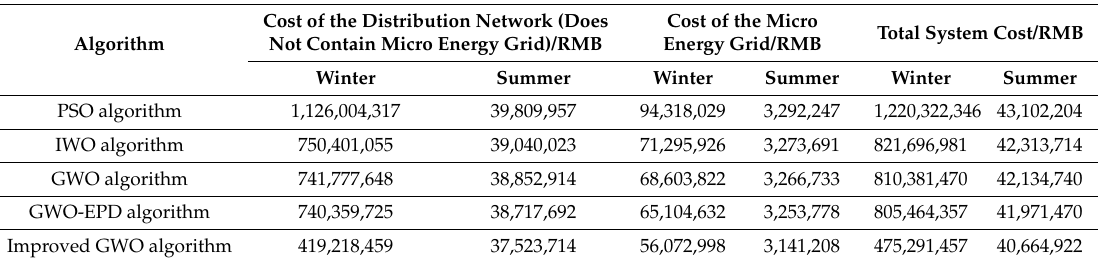
Table 6. Daily cost of the distribution network comprising the micro energy grid using five algorithms—the particle swarm optimization (PSO) algorithm, the invasive weed optimization (IWO) algorithm, the grey wolf optimization (GWO) algorithm, the improved GWO algorithm, and the GWO/evolutionary population dynamics (GWO-EPD) algorithm.